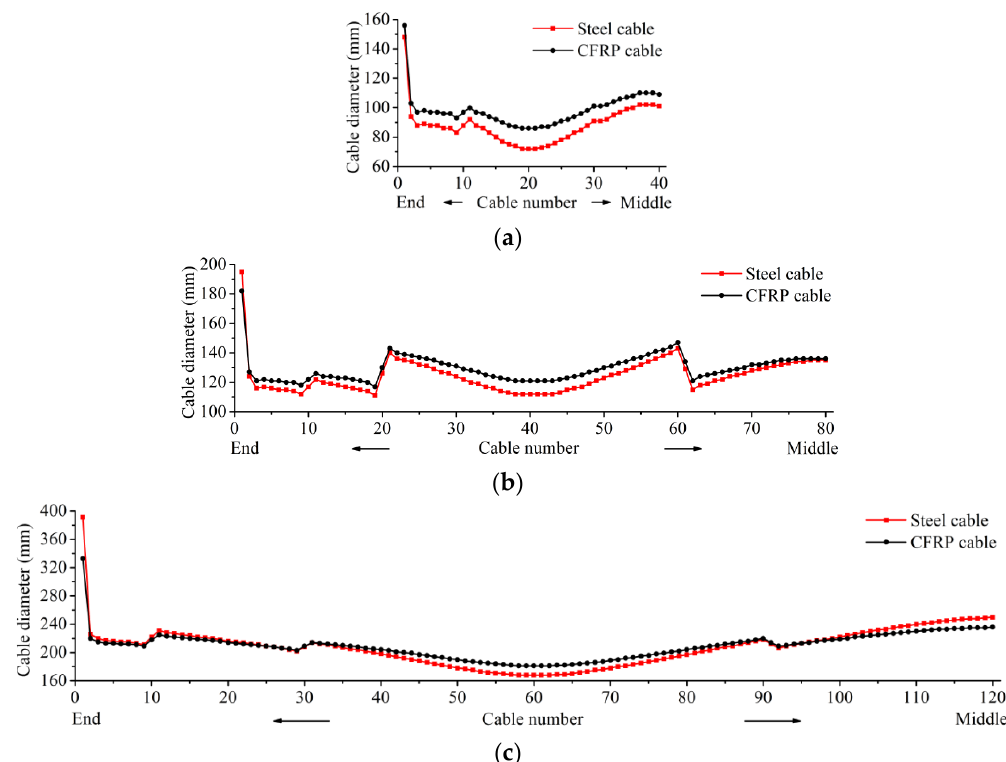
Figure 5. Diameters of the stay cables used: ( a ) main span = 600 m; ( b ) main span = 1200 m; ( c ) main span = 1800